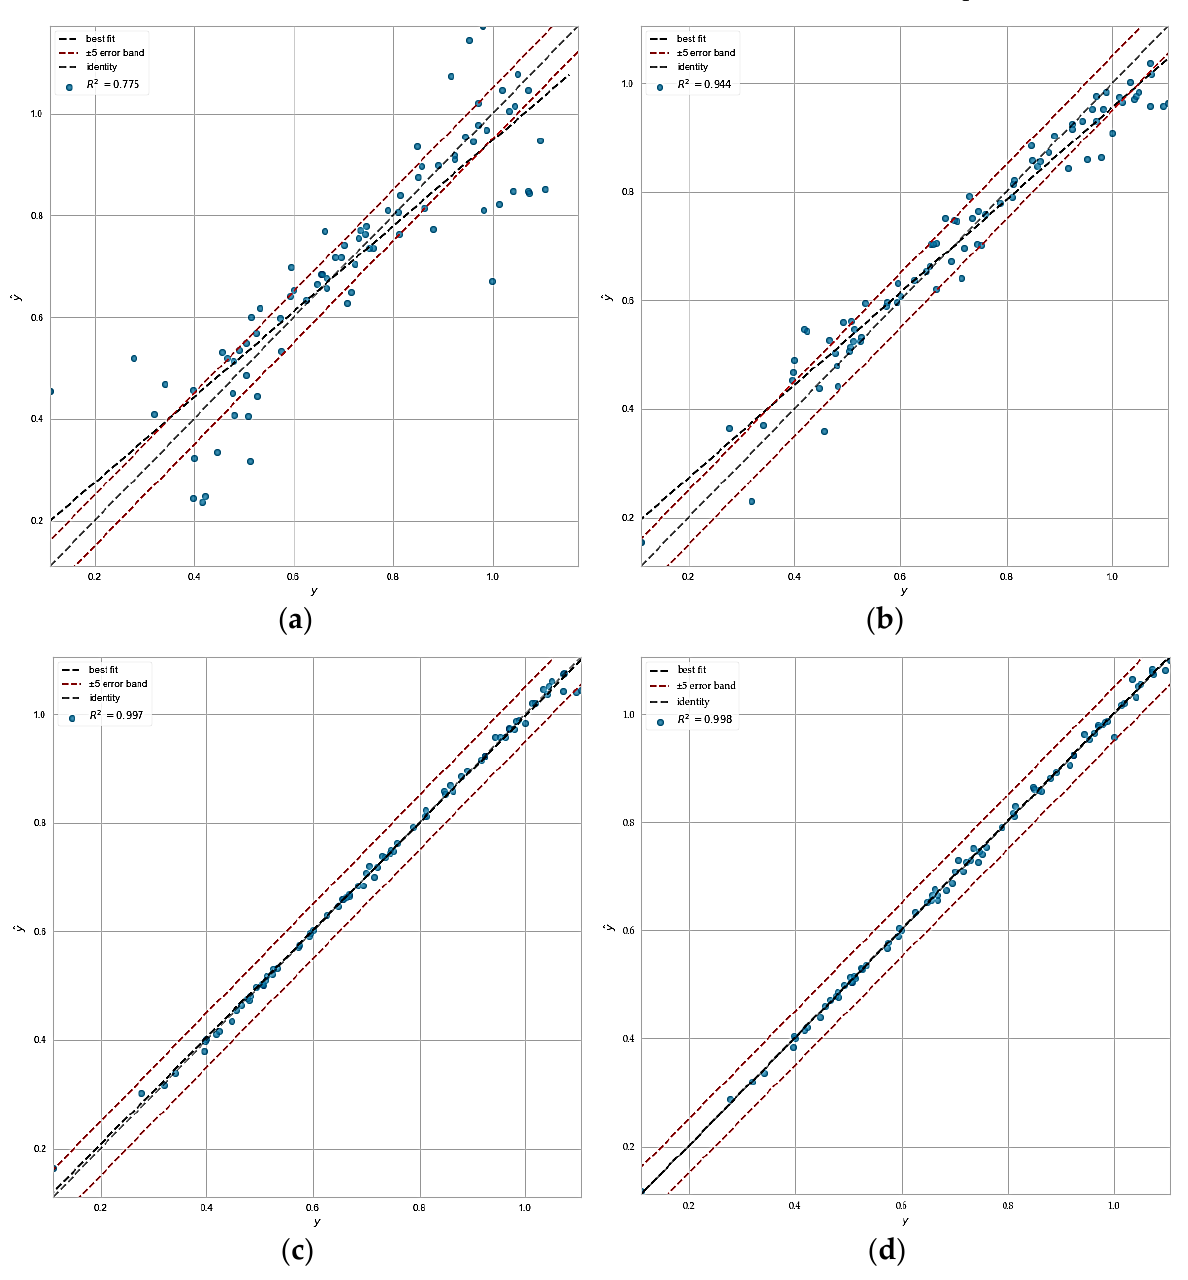
Figure 8. Different machine learning models’ prediction error on test data for ( a ) linear regressor; ( b ) support vector regressor; ( c ) Gaussian process; and ( d ) multilayer perceptron.